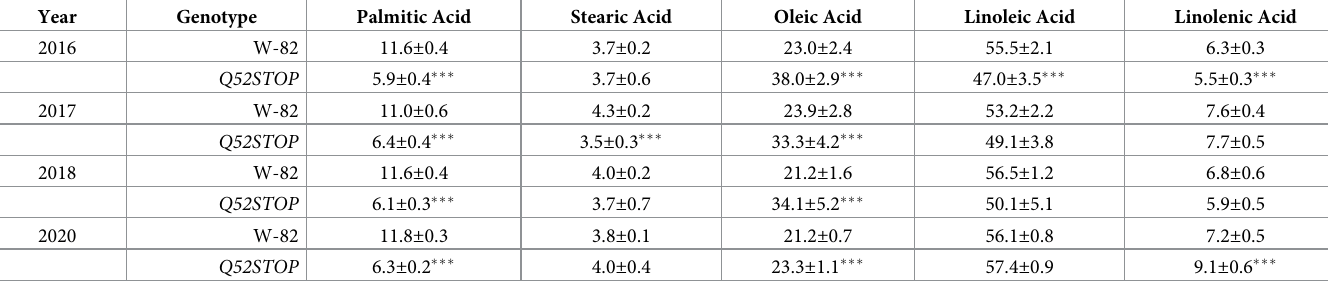
��� indicates significance level of p < 0.001 in Student’s t -test. Values are means of ten samples plus/minus standard